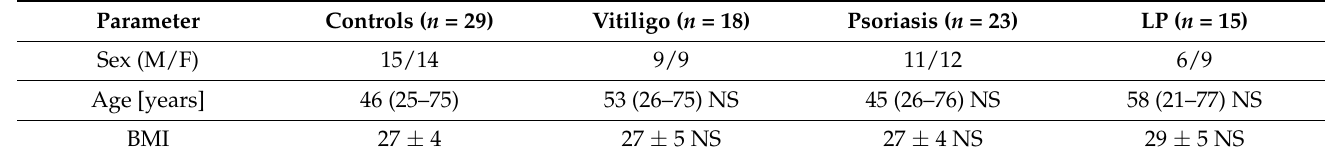
Table 1. Basic characteristics of patients and